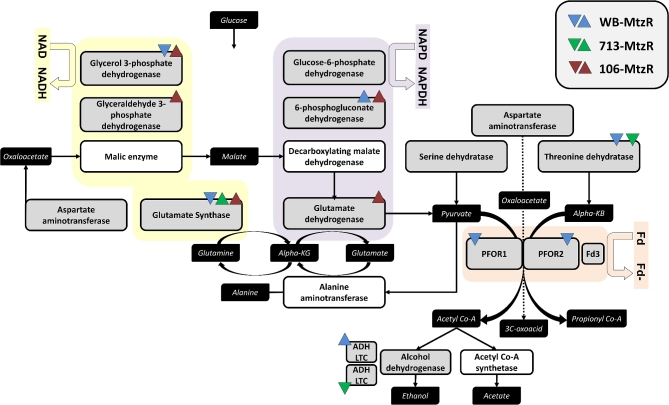
Differential protein expression in glycolysis and pyruvate catabolism. Pyruvate catabolism, with emphasis on enzymes with electron transport in upstream glycolysis. Enzymes with a white background were not identified in the protein dataset but have been included for completeness of pathway. Metabolites are shown in black boxes. Direction of differential expression in proteins is indicated using arrows and colors as designated in the top right corner. Fd, ferredoxin; ADH LTC, alcohol dehydrogenase lateral transfer candidate; KB, ketobutyrate; KG, ketoglutarate.